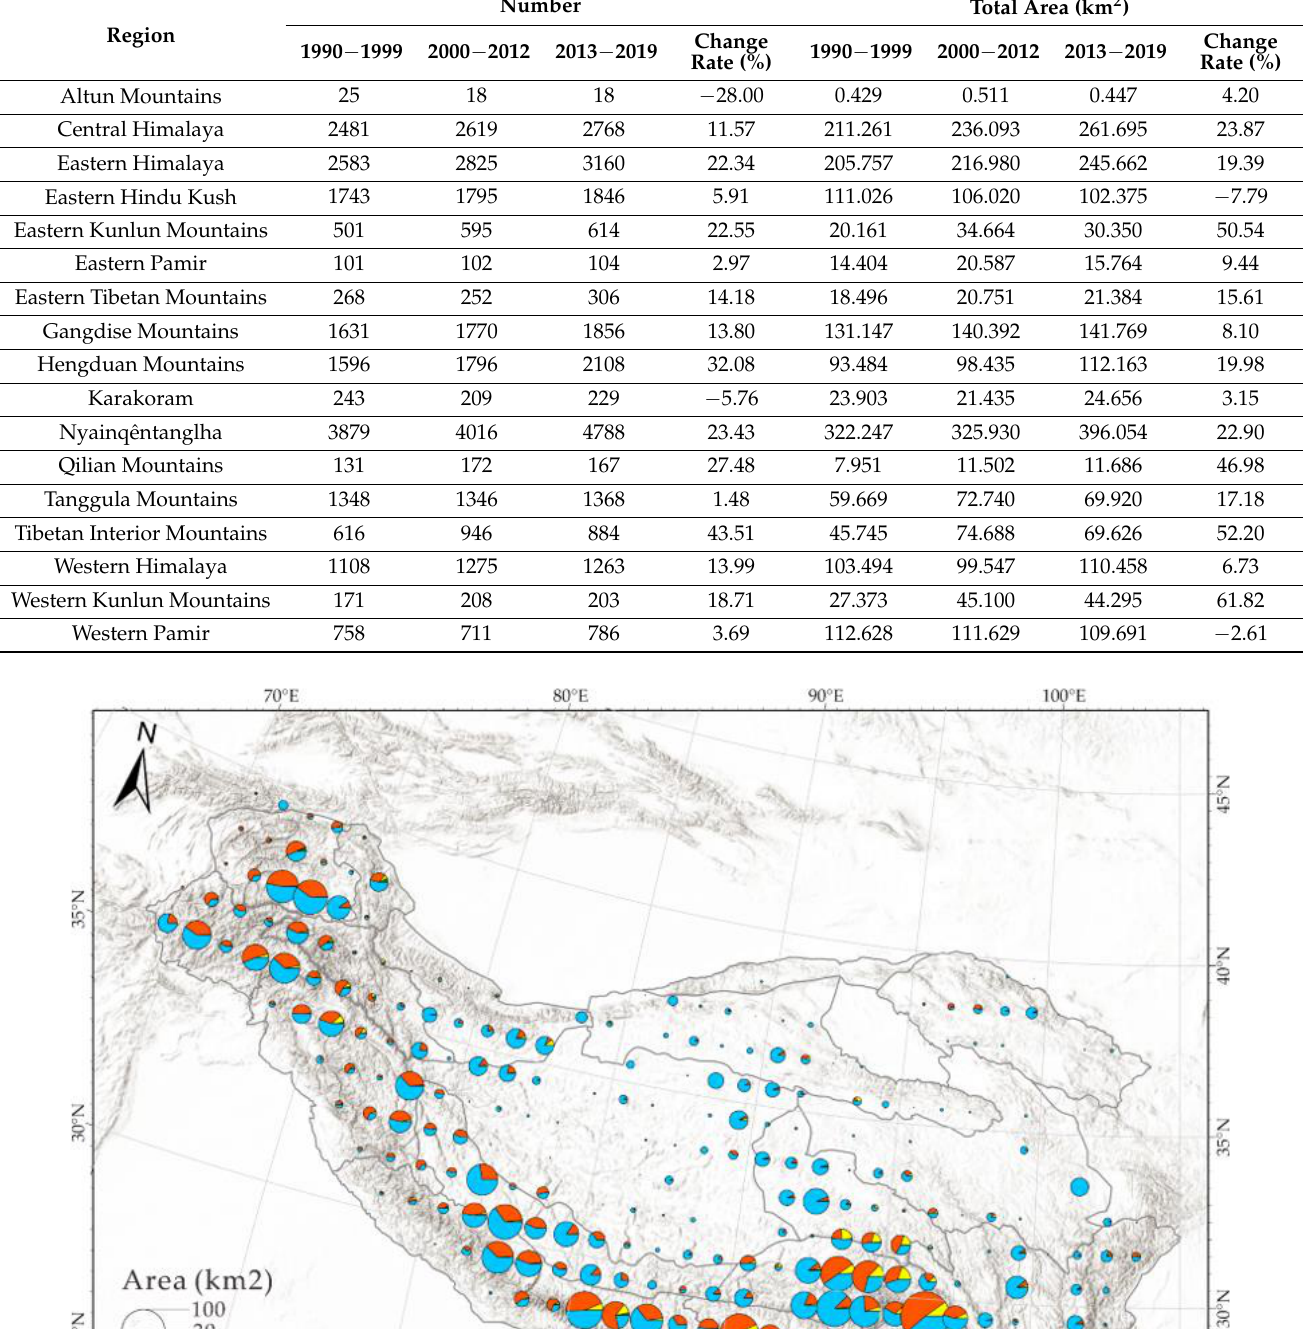
Figure 9. Proportional area distribution of four types of glacial lakes in the last period (2013 − 2019) on 1° × 1° grids. The circle size represents the total glacial lake area in the last period of each grid. The hillshade basemap is sourced from ESRI. Table 1. Regional summary of lake numbers and areas in each period.